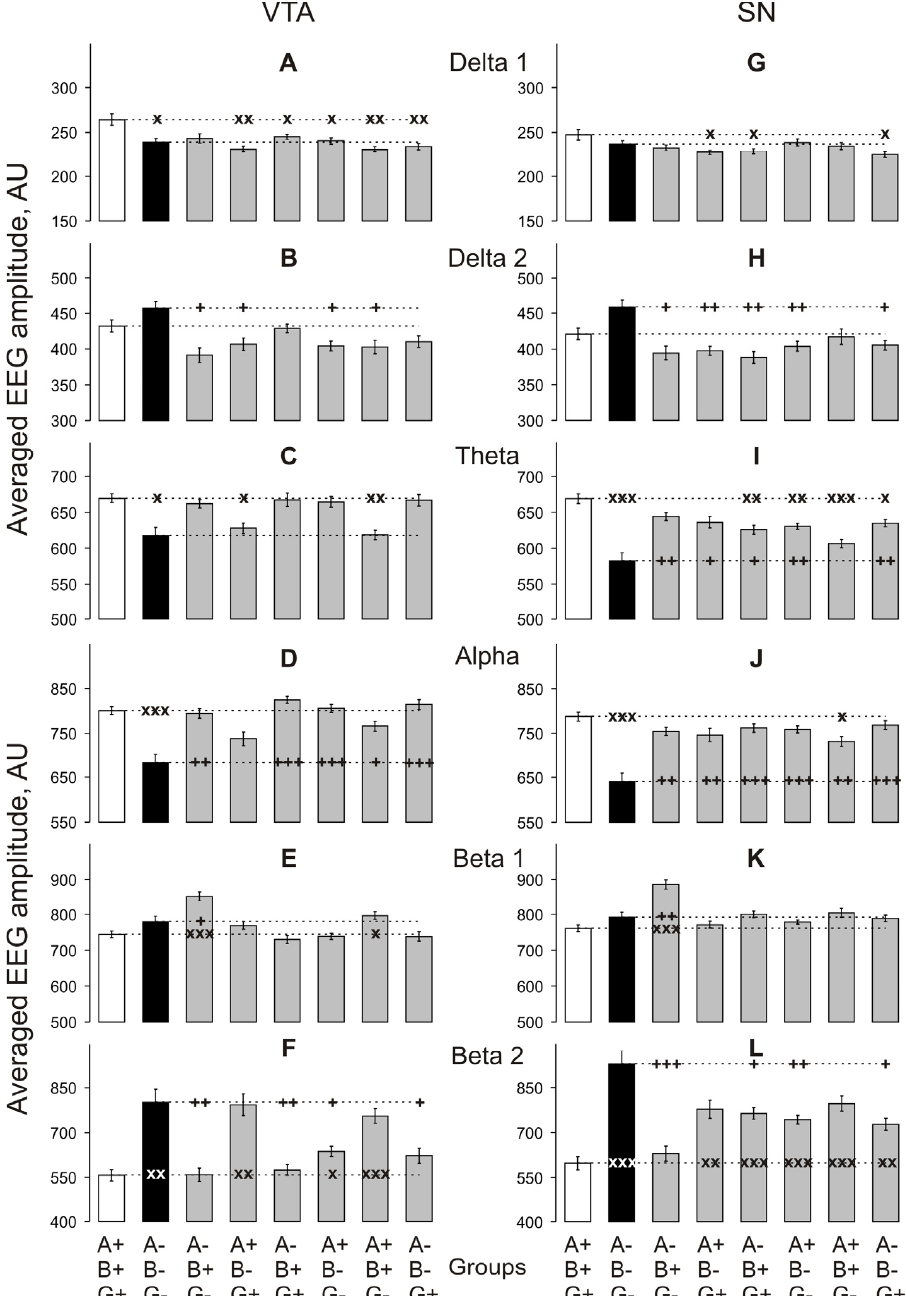
Figure 4. Relations between averaged amplitudes in “classical” frequency bands of 12 s baseline EEG fragments recorded from VTA ( A – F ) and SN ( G – L ) for 30 min in knockout mice of different types denoted on the horizontal axes. Ordinate is the averaged absolute values of EEG amplitudes in each of the “classical” bands, in arbitrary units (vertical lines are ± 1 SEM). Horizontal dashed lines denote the values in wild-type and triple-knockout groups: x and + symbols denote significant two-way ANOVA differences from the wild-type and triple-knockout mice, respectively (one, two and three symbols denote p < 0.05, < 0.01 and 0.001, respectively).